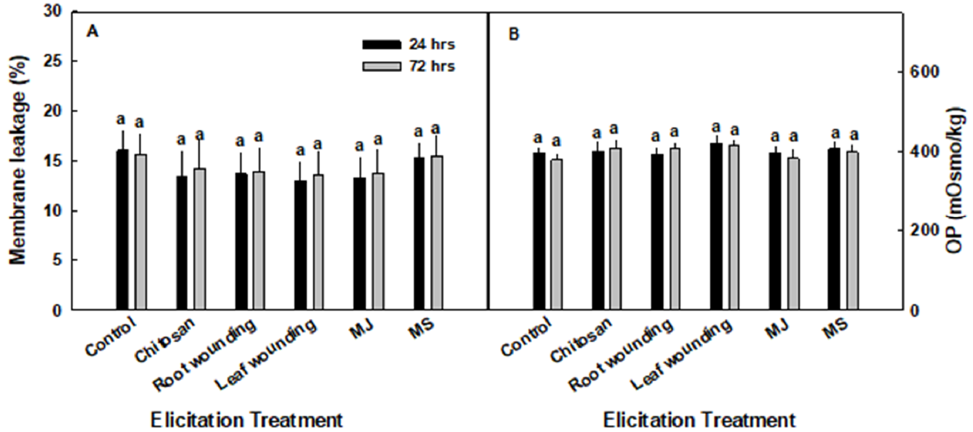
Figure 3. ( A ) Membrane leakage and ( B ) osmotic potential in elicited Turkey variety spinach plant leaves. The data represent means ± SE ( n = 5). Different letters above the means represent significant difference based on Tukey’s HSD test at α = 0.05.